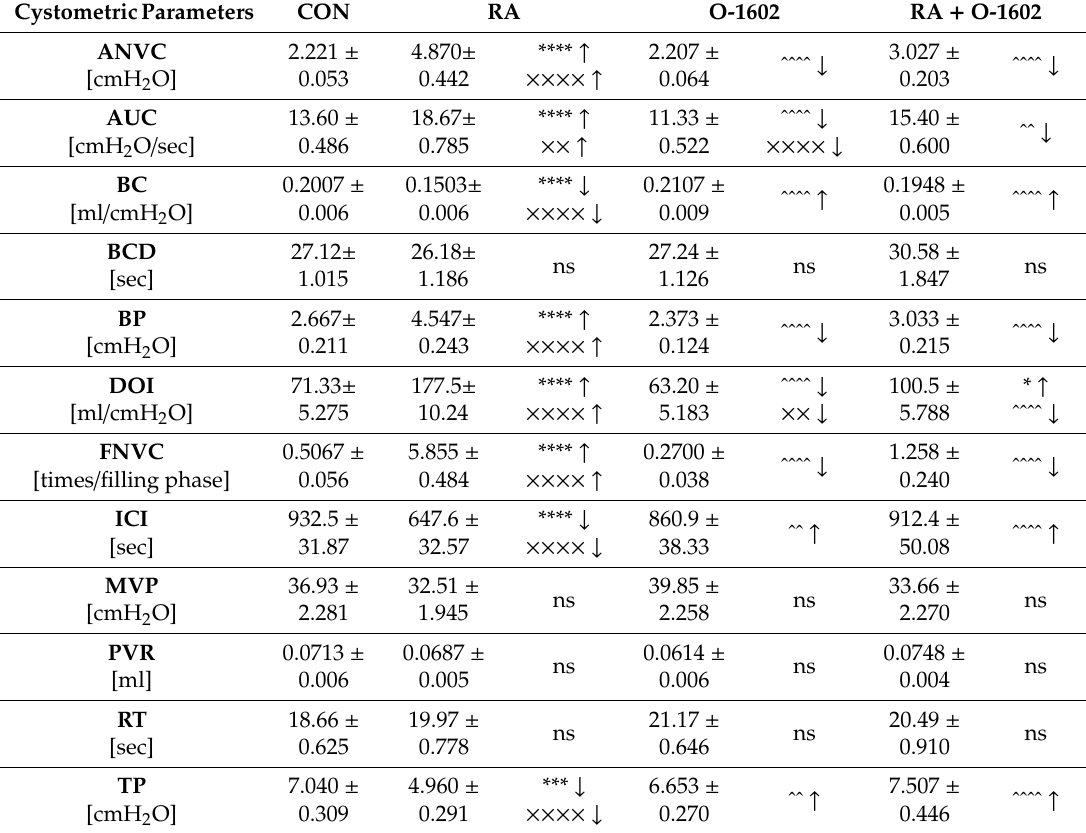
Table 1. The influence of O-1602 administration on the cystometric parameters in female rats with detrusor overactivity induced by retinyl acetate